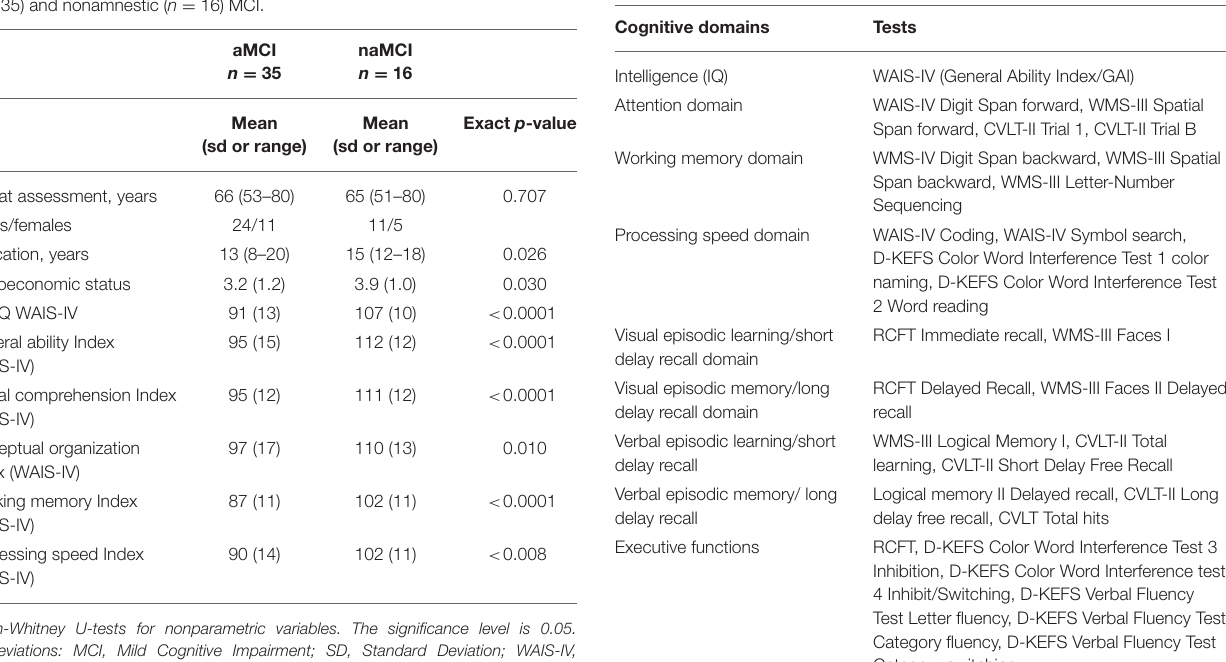
TABLE 3 | Assessed cognitive domains and neuropsychological